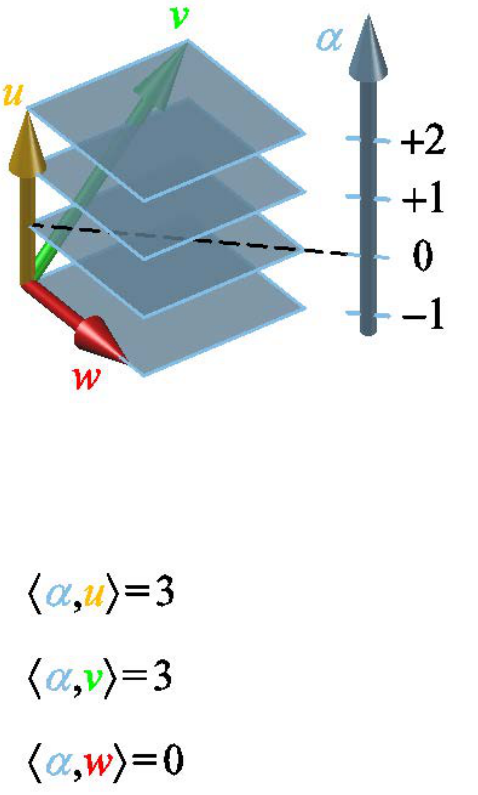
Figure 7: Linear functional (1-form) α and vectors u , v , w , in 3d Eu- clidean